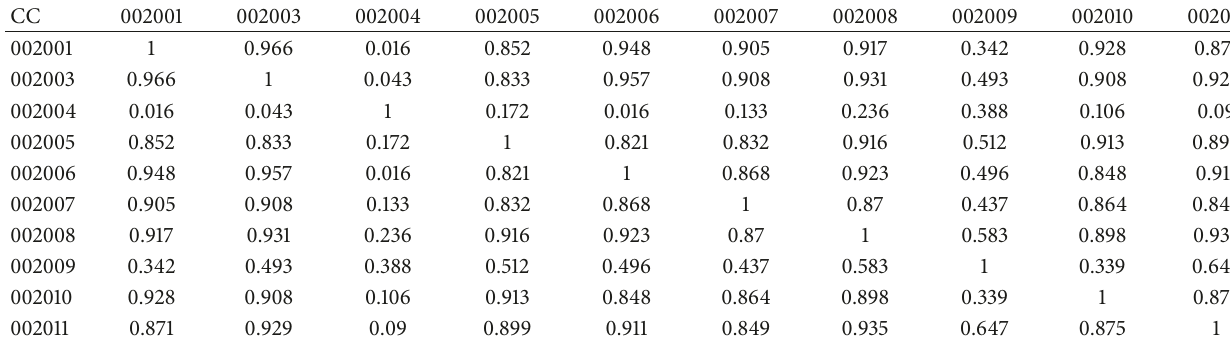
Table 5: True correlation matrix.